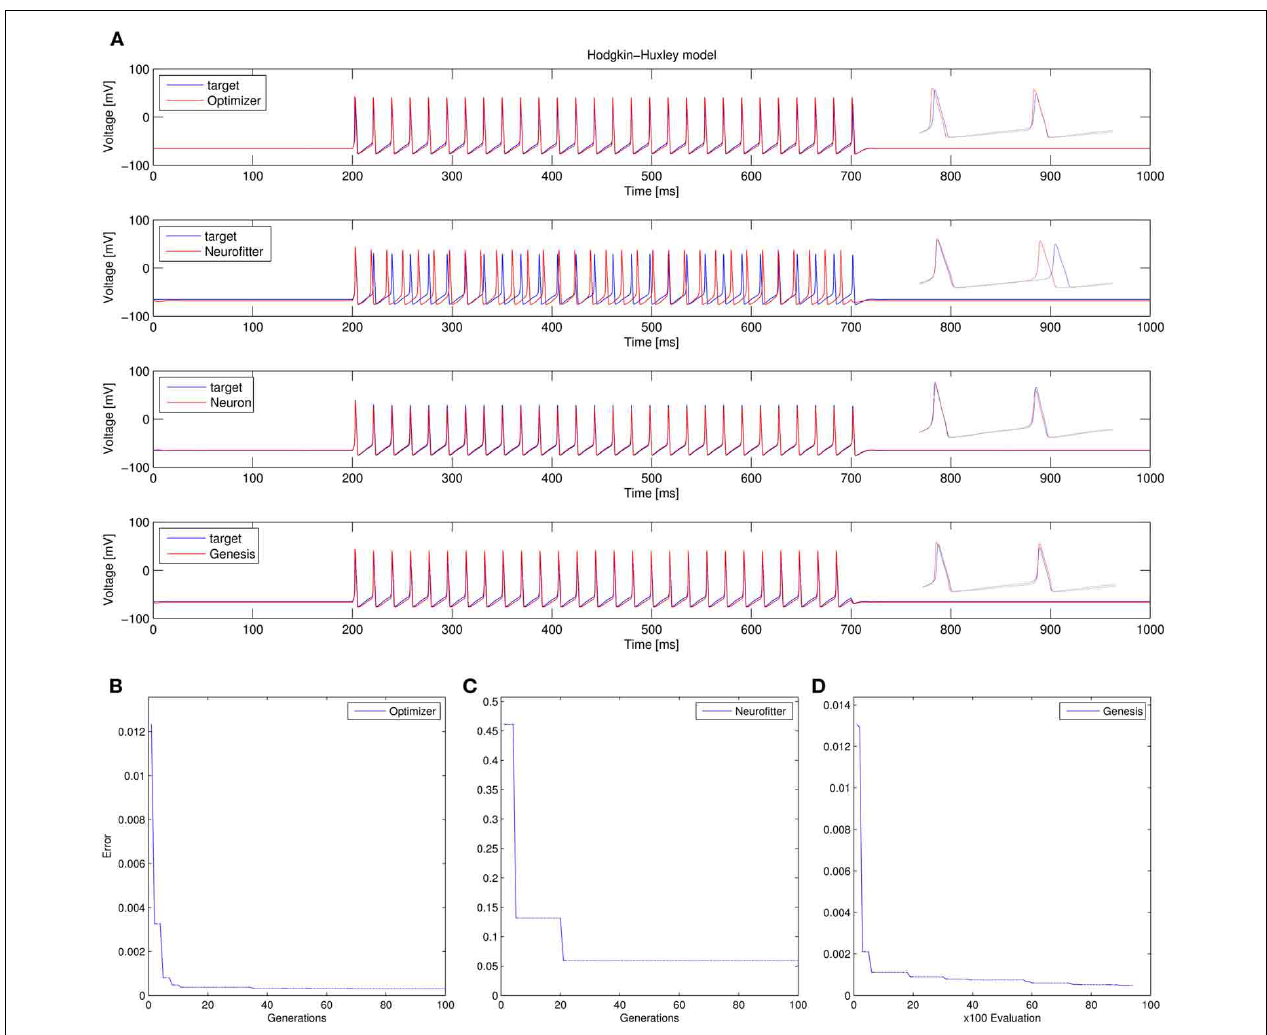
FIGURE 9 | Comparison of the performance of the four model fitting tools on Use case 1 (fitting conductance densities in the Hodgkin-Huxley model). (A) Comparison of the resulting best traces with the target trace. Insets show magnifications of spike shapes. (B–D) Changes